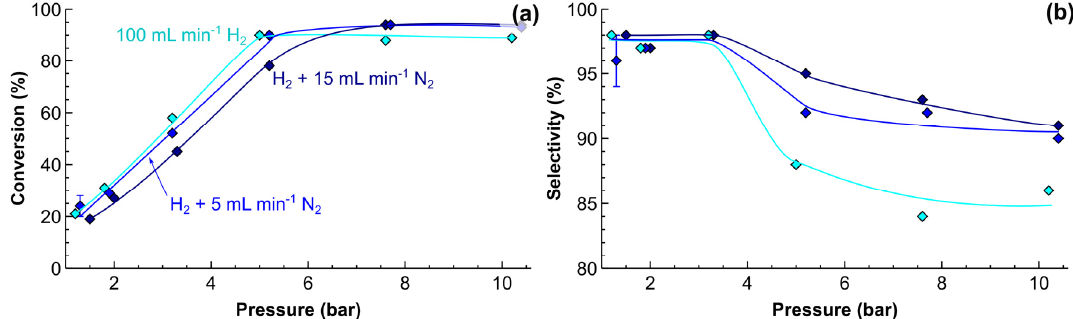
Figure 6. The effects of hydrogen pressure on ( a ) 2 ‐ methyl ‐ 3 ‐ butyn ‐ 2 ‐ ol (MBY) conversion and ( b ) 2 ‐ methyl ‐ 3 ‐ buten ‐ 2 ‐ ol (MBE) selectivity. Reaction conditions: solvent ‐ free MBY flow 400 μ L min − 1 , 100 mL min − 1 (standard temperature and pressure, STP) H 2 with the addition of either 0, 5 or 15 mL min − 1 (STP) N 2 . The reaction temperature of 50 °C inside a 5 m reactor coated with a 5 wt% Pd/ZnO catalyst.